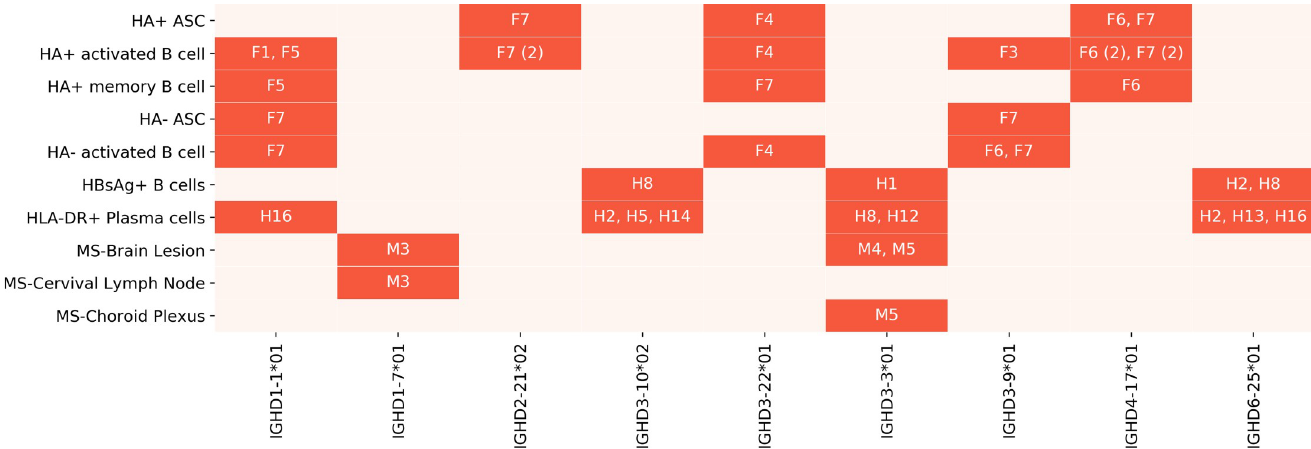
Fig 12. Summary of overused genes in Stimulated datasets. The datasets in which each gene is overused are highlighted and annotated with the corresponding individuals. Subjects were prefixed with a letter corresponding to the project–“F” for Flu Vaccination, “M” for Multiple Sclerosis, and “H” for Hepatitis B Vaccination. Some genes were overused in multiple datasets from the same and/or different individuals. The number in parentheses shows the number of datasets from the same individual in which the gene was overused.